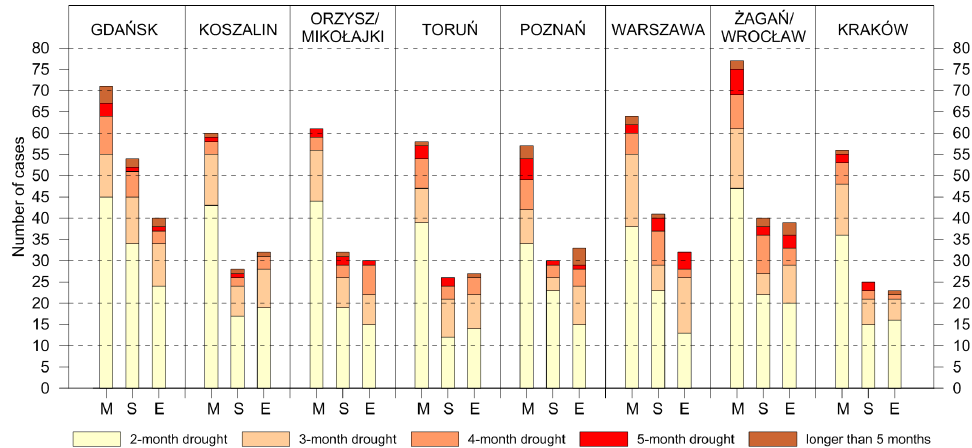
Figure 11. Average frequency of three categories of droughts (M: moderate, S: severe, E: extreme) in Poland per century stratified by duration (1722–2015).